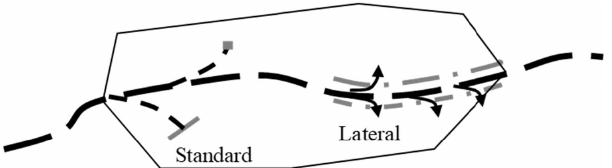
Figure 2. Standard and lateral